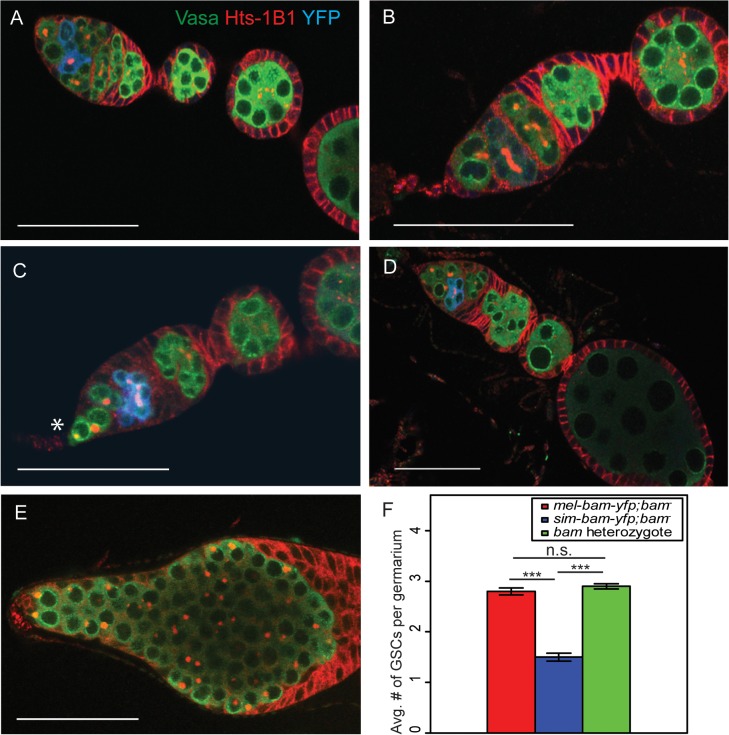

sim-bam-yfp; bam
−ovaries have multiple defects.(A-B) mel-bam-yfp; bam
−ovaries show wildtype morphology including proper Bam-YFP expression, correct number of GSCs identified by spectrosomes, and proper numbers of cells/cyst. (C-D) sim-bam-yfp; bam
−ovaries show reduced number of GSCs (*) and contain egg chambers with improper number of cells/cyst. (E) D. melanogaster bam null mutant shows “bag of marbles” phenotype. (A-E) Ovaries are from flies aged 3–5 days post-eclosion and stained with antibodies to Vasa (green), Hts-1B1 (red), and YFP (blue). Scale bar, 50μm. (F) Average GSC number across different genotypes. N = 50 ovarioles. (t-test, ***P<0.001).